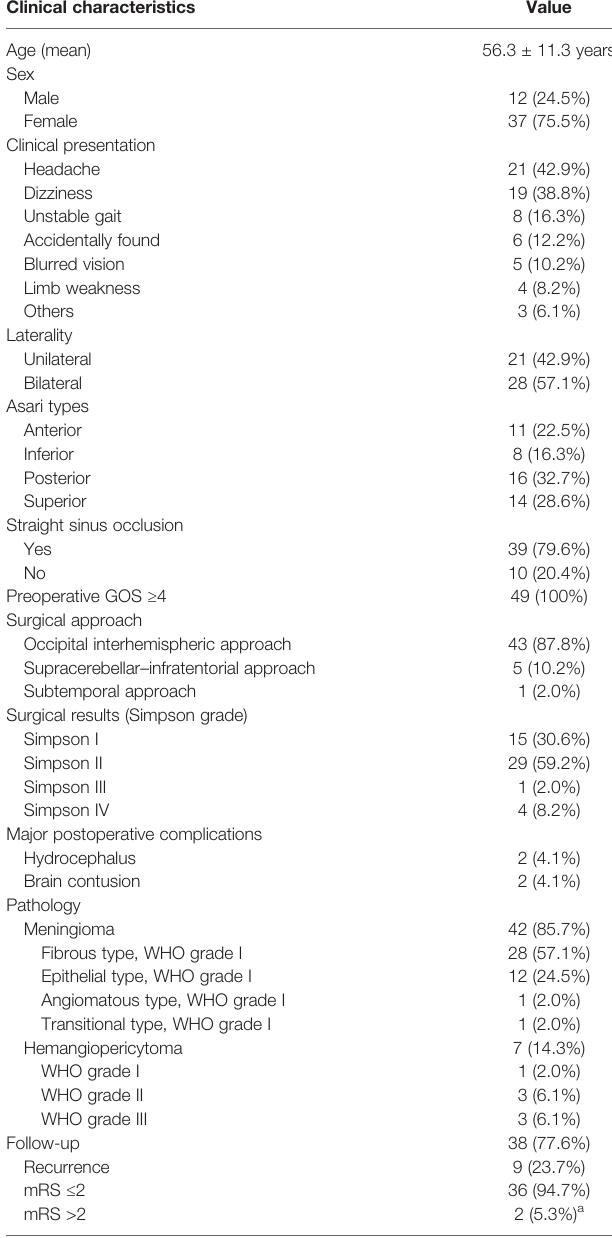
TABLE 1 | Clinical characteristics of patients with falcotentorial junction tumors. Clinical